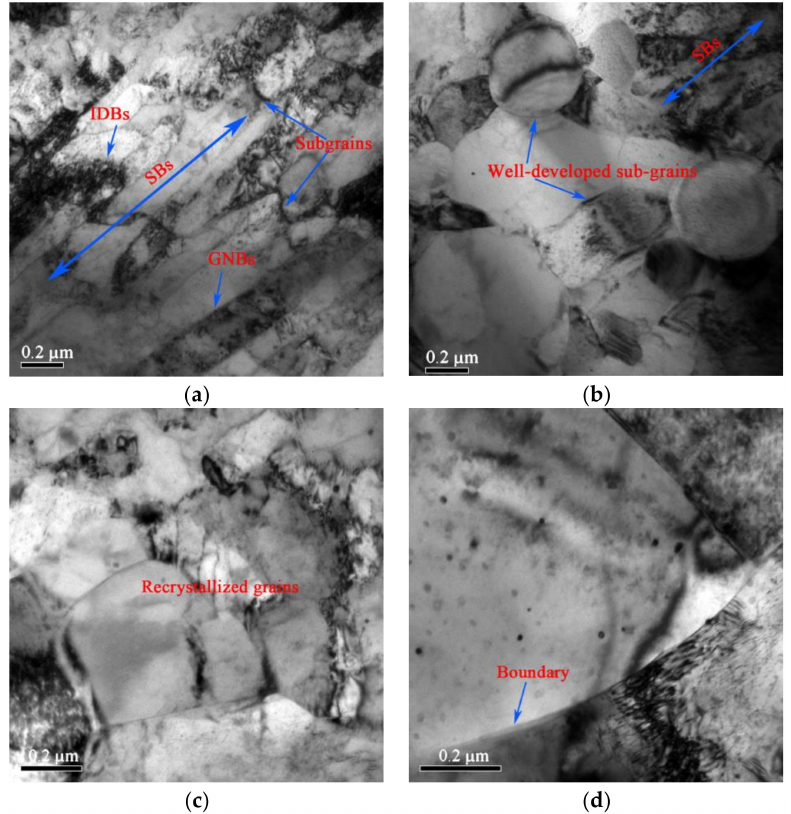
Figure 4. Bright-field (BF) images of Cu-Cr-Zr alloys with 240-min-aged initial states at ( a ) 723 K, and 60-min-annealed states at different temperatures of ( b ) 823 K, ( c ) 873 K, and ( d ) 973